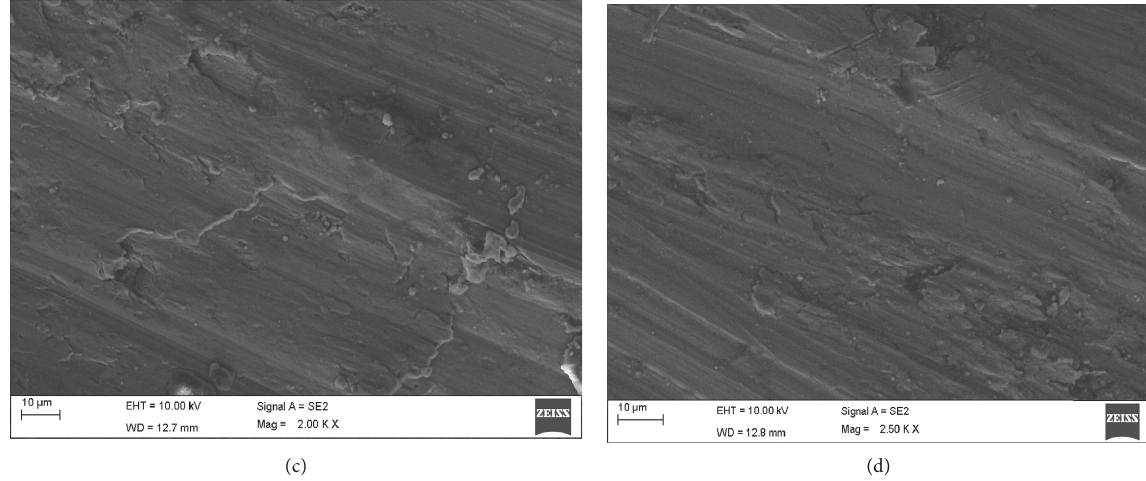
Figure 10: SEM analysis for 5% of reinforcement Al composite with glass fibre.